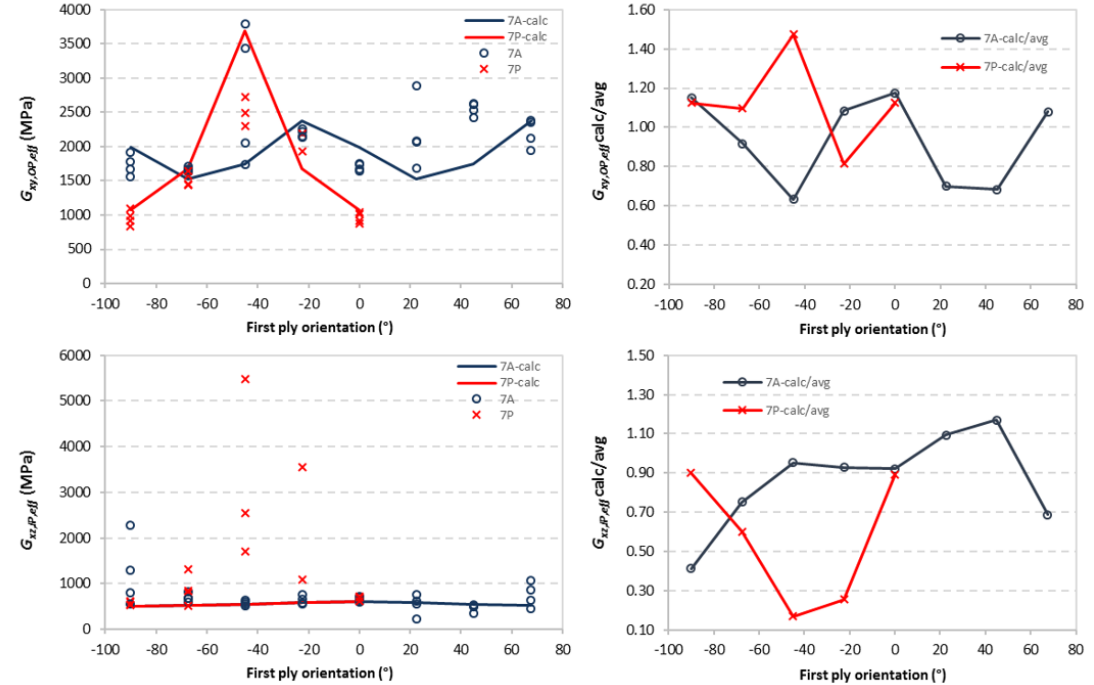
Figure 7. Calculated and measured e ff ective modulus of elasticity and shear modulus for 7-layer samples for di ff erent combinations of layer orientations. The points represent single values obtained from the natural frequencies of flexural, torsional and longitudinal vibrations. Solid lines represent calculated values using the laminate